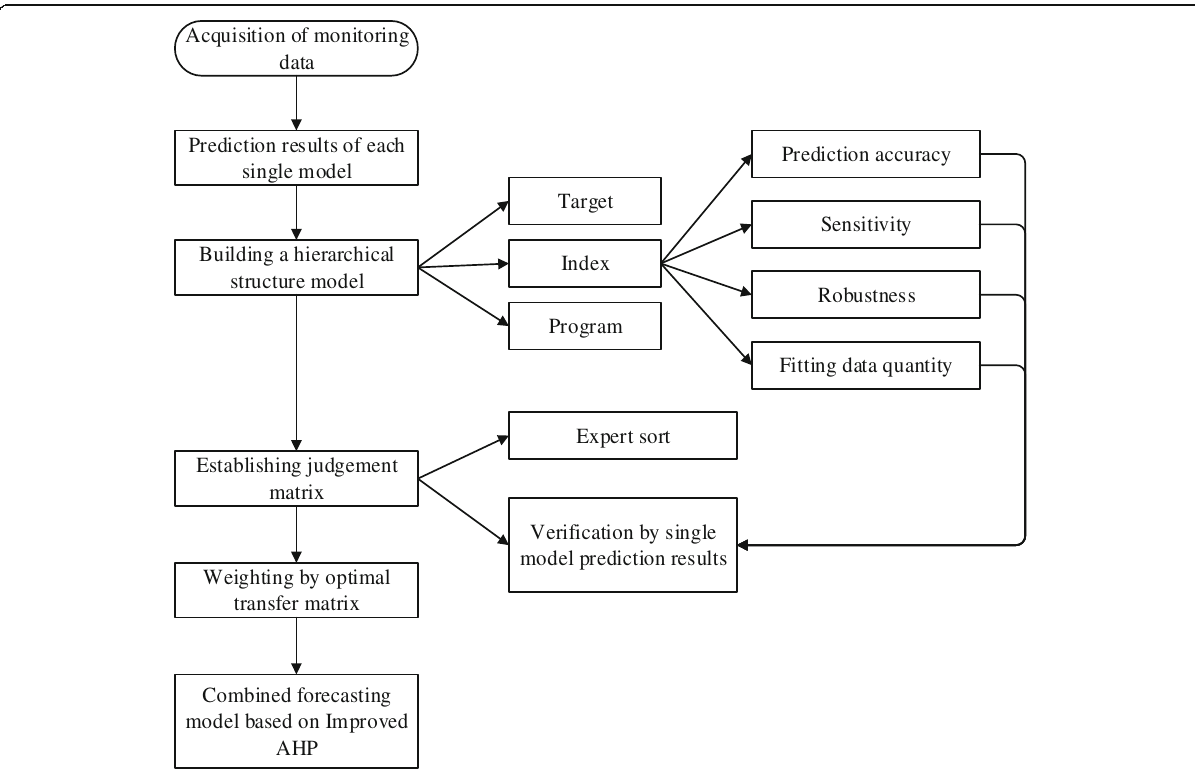
Fig. 2 Flowchart of construction of the combined model. In order to make readers understand the whole structure of the combined model more clearly, there is a flowchart from data preparation to determine the weight of each single model. The detailed solution steps can be seen in Section 3